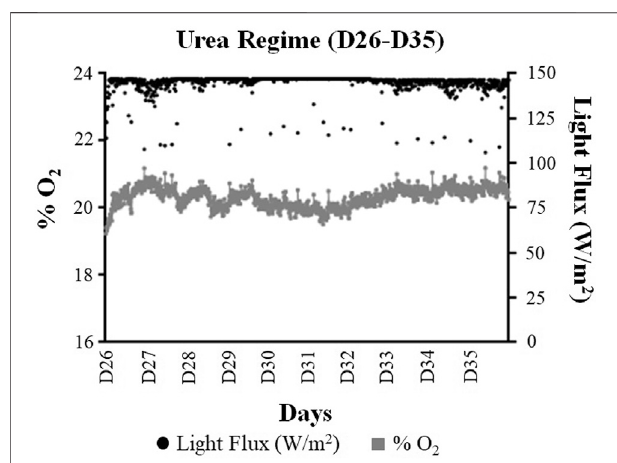
FIGURE 6 | Comparison of the average oxygen (% O 2 ) and light fl ux (W/m 2 ) values obtained during the urea regime of the ground demonstration (Day 26 – Day 33). For the graphical representation of data, the values have been reported as the 15-min average of each analyte.